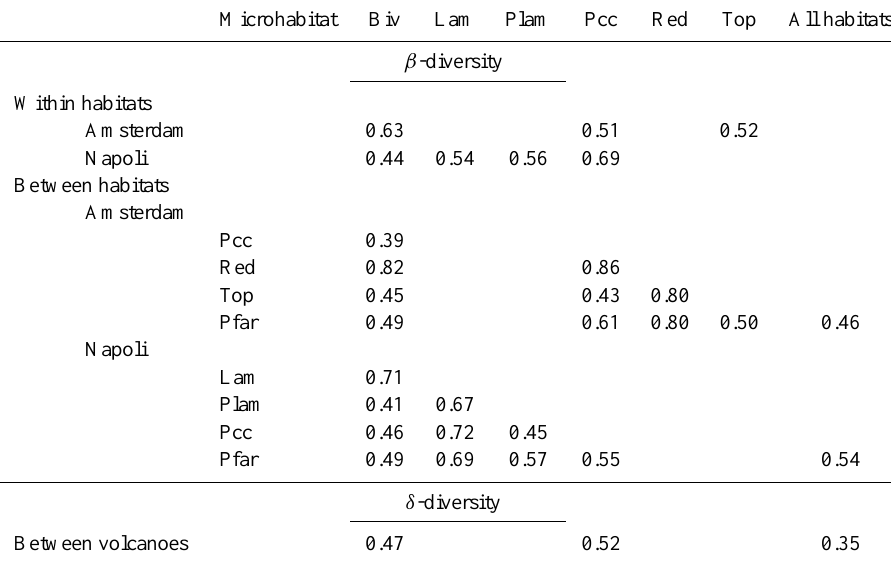
Table 6. Beta and delta diversity based on Jaccard dissimilarity. Dissimilarity increases from 0 to 1 (Biv: bivalve shells; Pcc: periphery of carbonate crusts; Red: reduced sediments; Top: summit of the mud volcano; Lam: Lamellibrachia microhabitat; Plam: periphery of Lamellibrachia ; Pfar: far